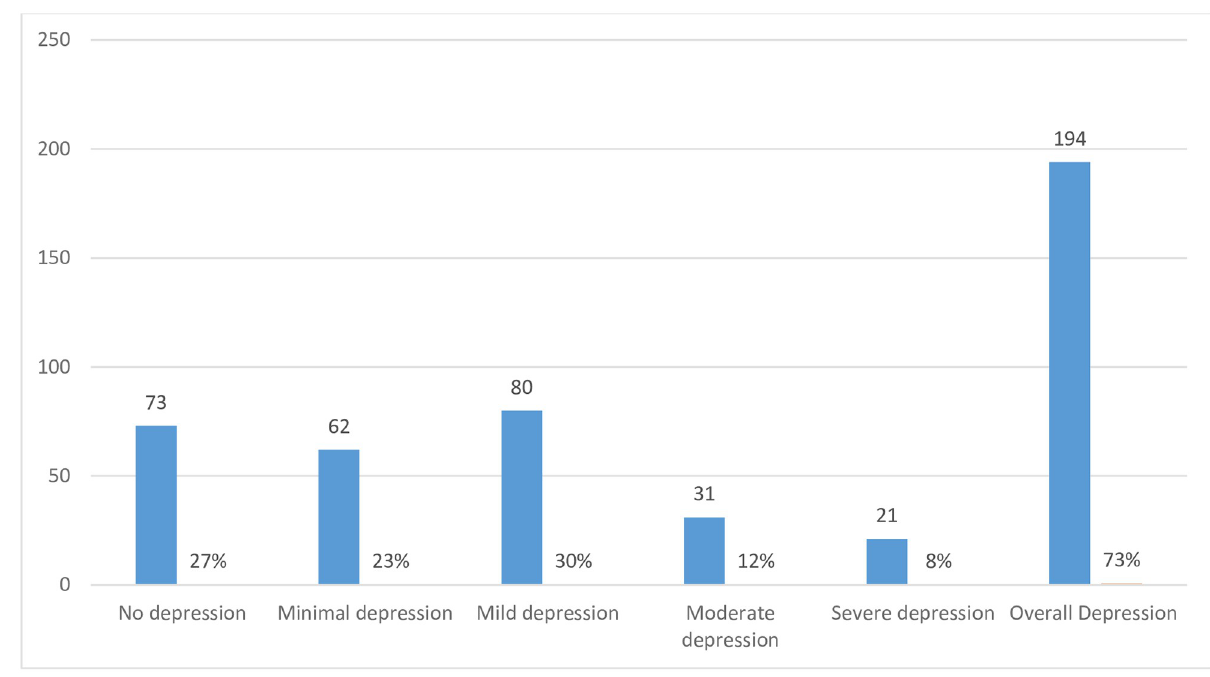
Fig 1. Prevalence of depression among patients with diabetes at